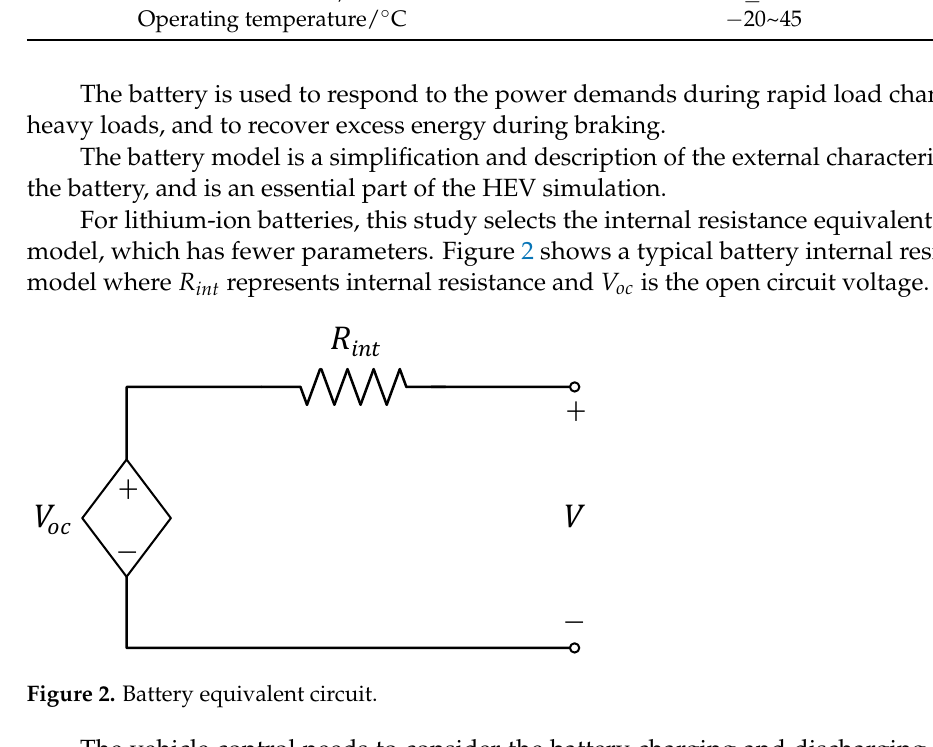
Figure 2. Battery equivalent